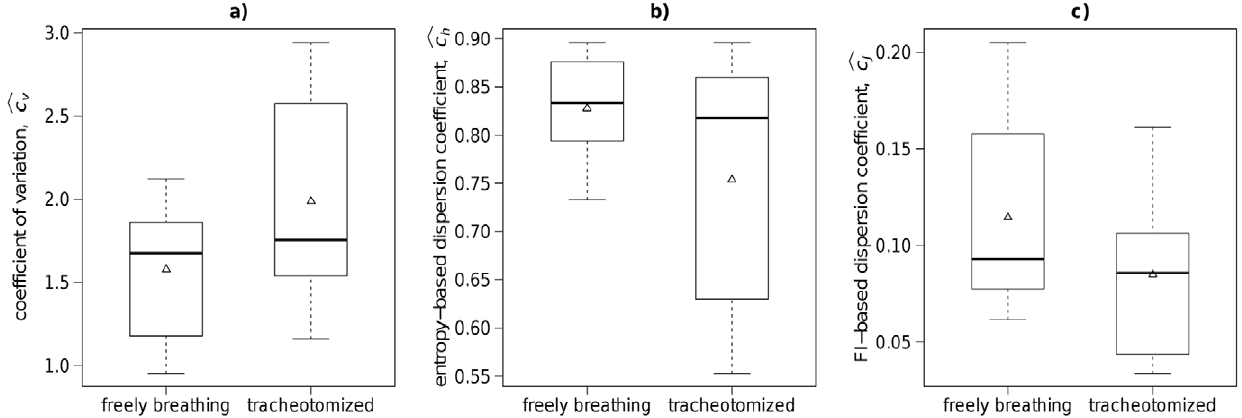
Figure 10. Box-and-whisker plots of estimated dispersion coefficients. The coefficients c v (panel a ), c h (panel b ), and c J (panel c ) estimated from the experimental data (spontaneously active rat olfactory neurons) are shown for two categories: freely breathing and tracheotomized rats. The lower and upper sides of the boxes denotes the first ( Q 1 ) and third ( Q 3 ) quartile, thick lines inside the boxes are medians, triangles denote mean values. The whiskers show the lowest and greatest data value between Q 1 { 1 : 5 | IQR and Q 3 z 1 : 5 | IQR (where IQR ~ Q 3 { Q 1 is interquartile range).